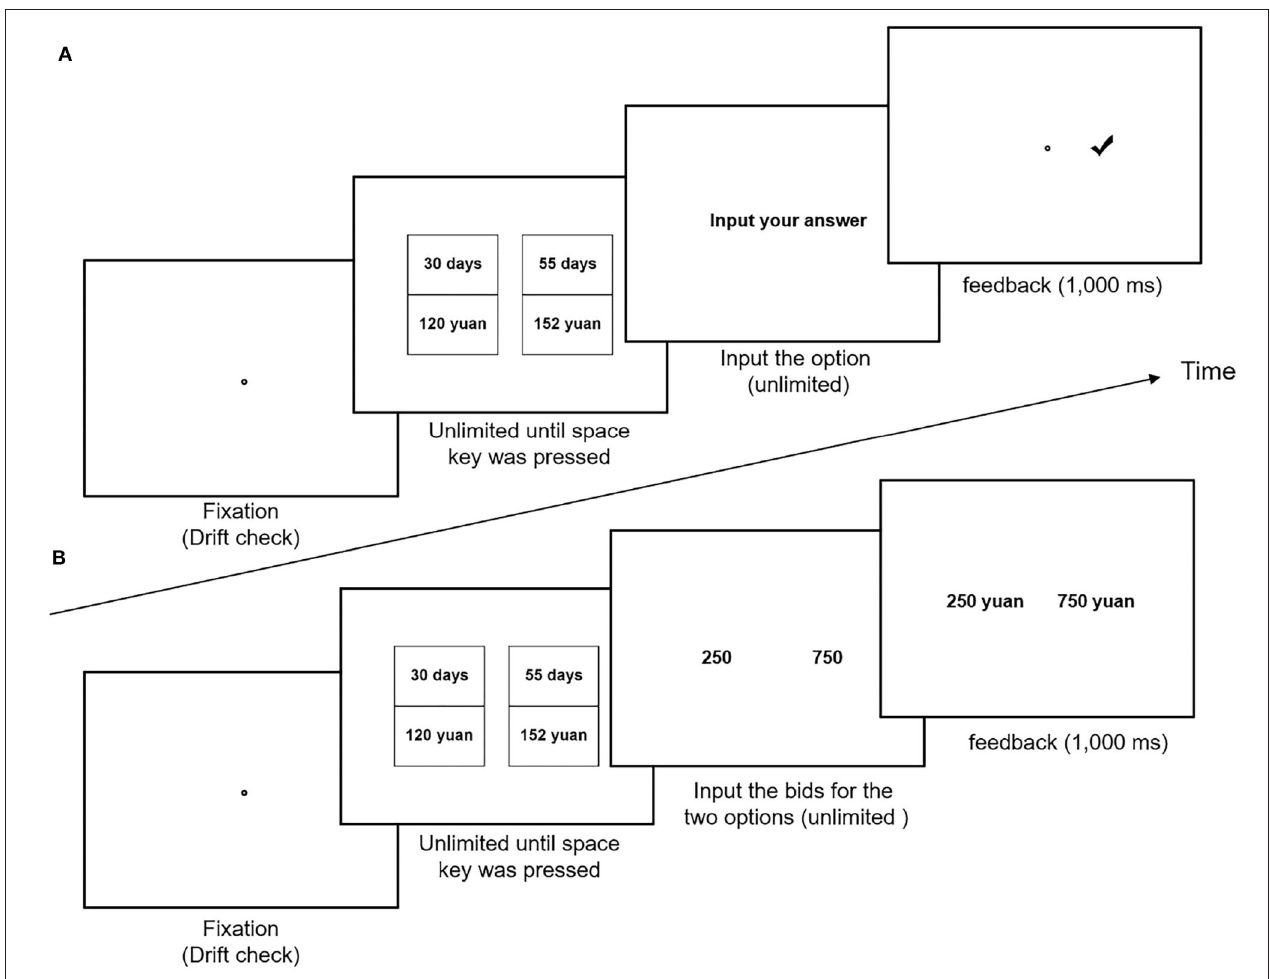
FIGURE 1 | Trial procedure and timing in (A) the choice task, the hybrid task, and (B) the bid task.